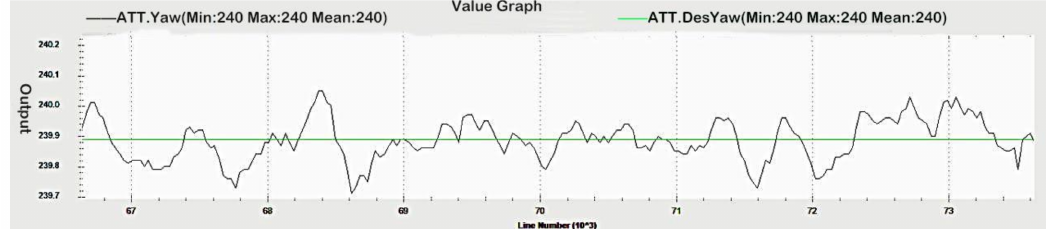
Figure 8. The angle fluctuation curve of the UAV under test condition 4. The curve in the graph is the sampling point curve, where the unit of the vertical coordinate is degree. The green line is the expected value, the red line is the unmanned aerial vehicle dual antenna to calculate the direction angle, the fluctuation amplitude is small, and it is 0.3